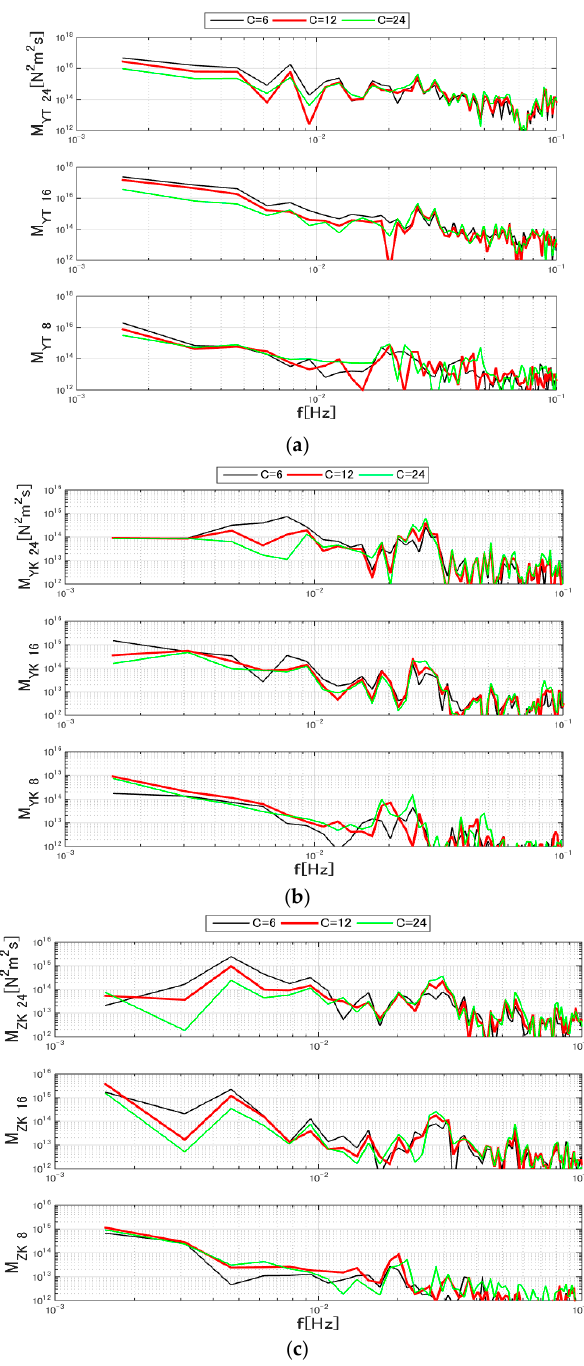
Figure 14. PSD of the tower loads (24 m/s, 16 m/s and 8 m/s from top to bottom): ( a ) tower base fore ‐ aft bending; ( b ) tower top nodding; and ( c ) tower top yawing.